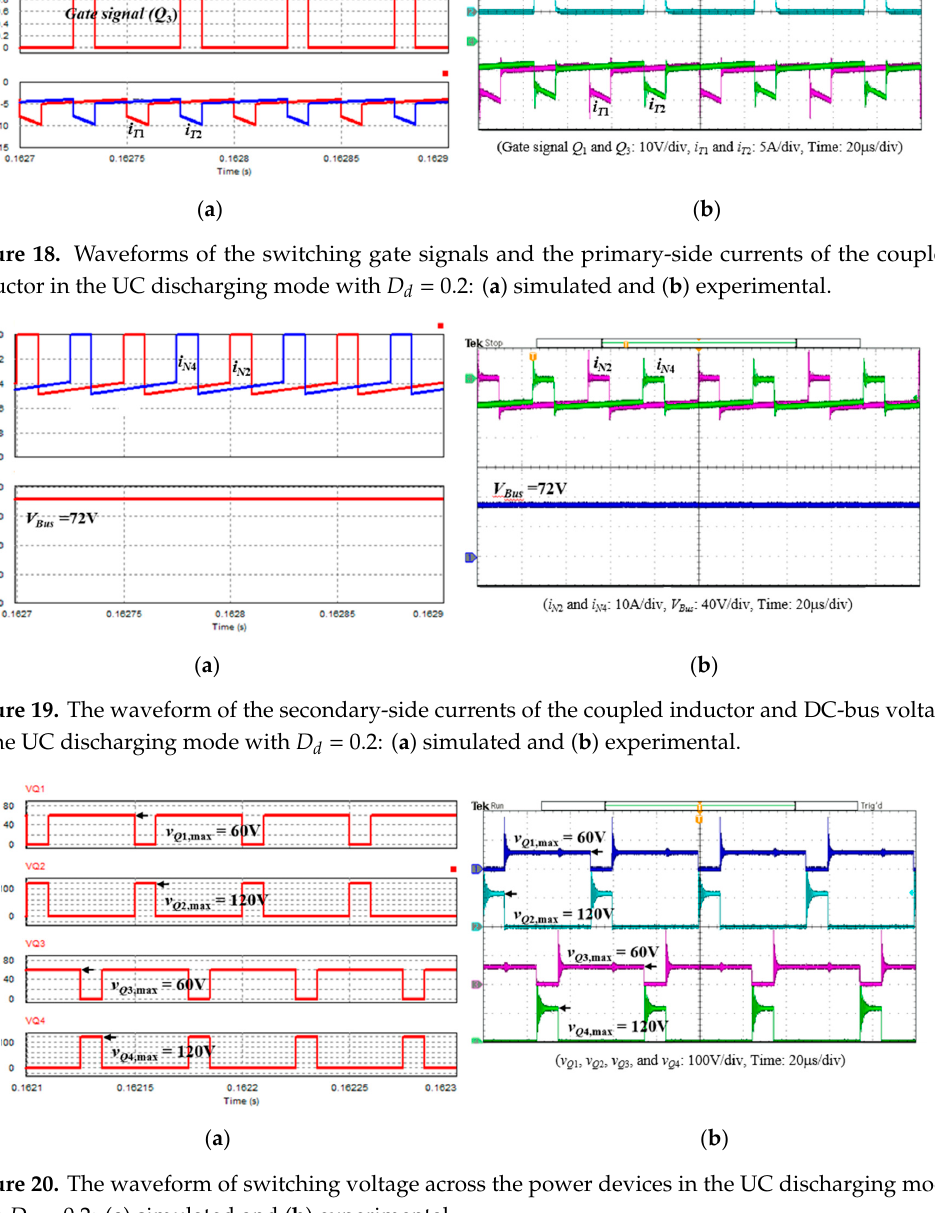
Figure 20. The waveform of switching voltage across the power devices in the UC discharging mode with D d = 0.2: ( a ) simulated and ( b ) experimental.